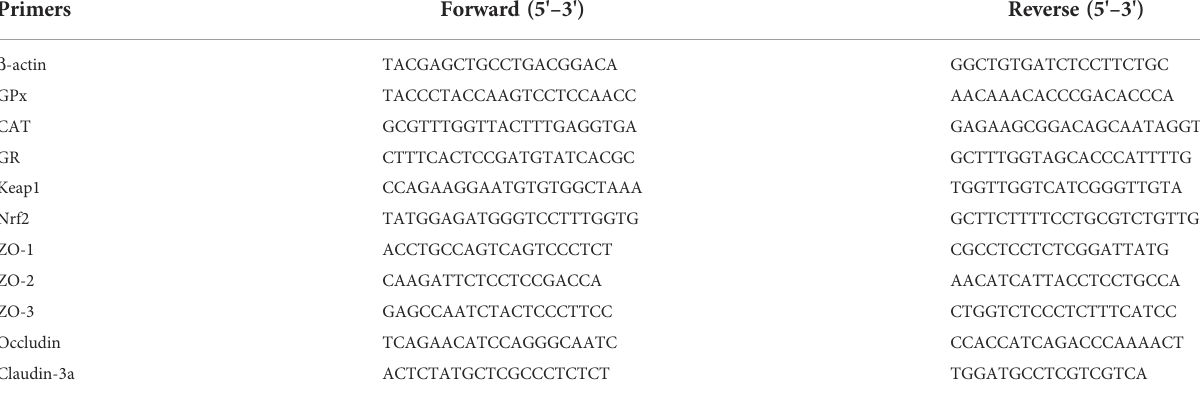
TABLE 2 Sequences of the PCR primers used in this